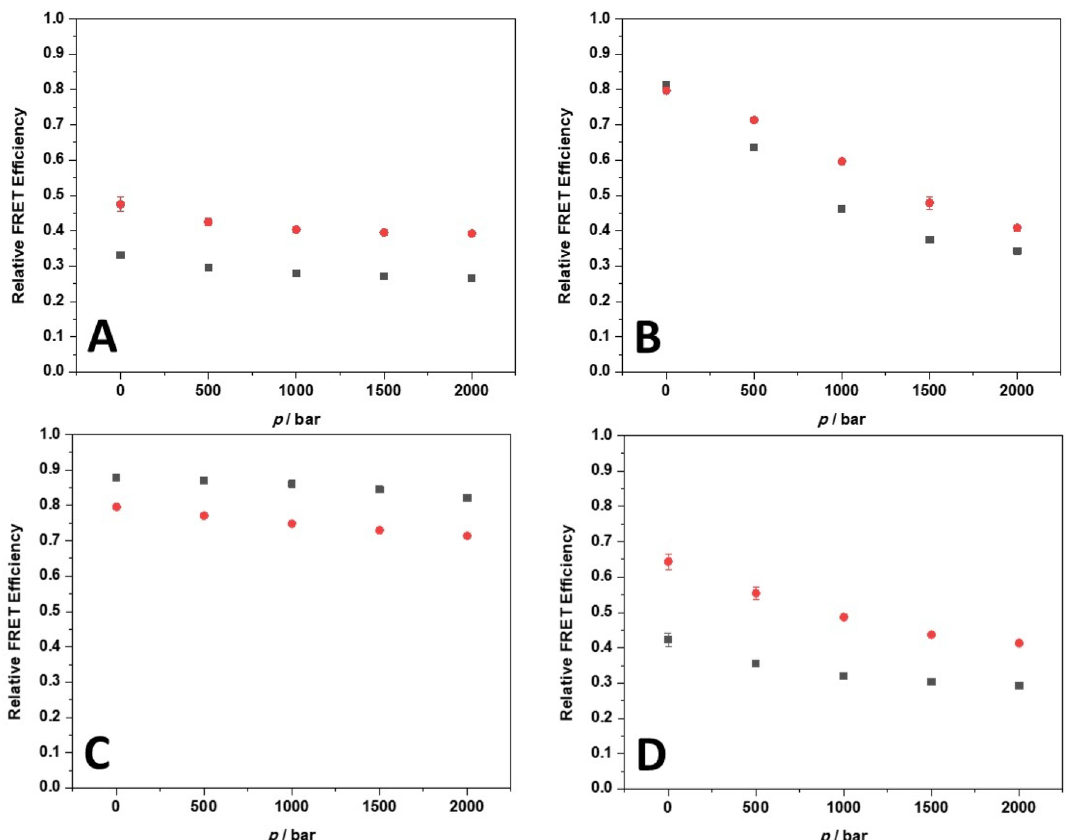
Figure 3. Plots of the relative FRET efficiency ( E rel ) as a function of pressure for the dually labelled 22AG in the absence (black squares) and in the presence (red circles) of ThT (ThT:22AG ratio = 10:1) in ( A ) 30 mM Tris, pH 7.4, ( B ) in the presence of 60 mM NaCl, ( C ) in the presence of 60 mM KCl, and ( D ) in the presence of 25 wt% Ficoll. All the experiments were carried out in triplicate at 25 °C. Where not shown, the error bars are smaller than the symbol